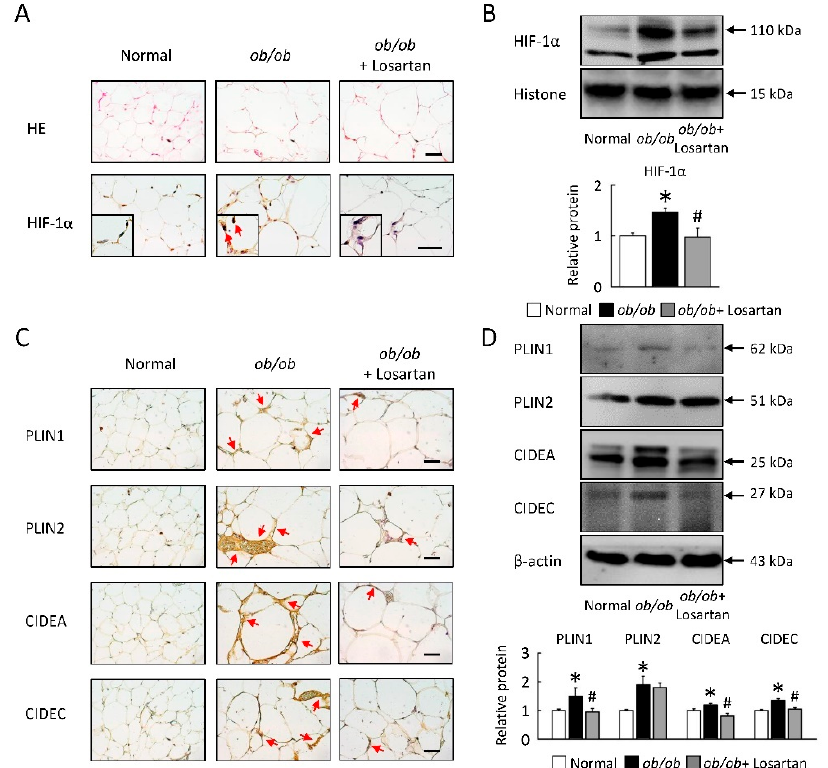
Figure 6. Losartan attenuated HIF-1 α expression and LDs formation in EWAT. ( A ) Representative HIF-1 α staining of EWAT from losartan-treated ob / ob mice and normal mice. Red arrow highlights the positive staining. Scale bar: 100 µ m. Quantification of ( B ) HIF-1 α protein level by Western blot. Below graphs indicate quantification relative to Histone. ( C ) Representative HE, PLIN1, PLIN2, CIDEA and CIDEC staining of EWAT from losartan-treated ob/ob mice and normal mice. Scale bar: 100 μ m. Quantification of ( D ) PLIN1, PLIN2, CIDEA, and CIDEC protein levels by Western blot of EWAT after losartan treatment. Below graphs indicate quantification relative to β -actin. For each animal group, n = 5. All values represent the mean ± SEM. Data were analyzed by Student’s t test. * p ≤ 0.05; normal vs. ob/ob . # p ≤ 0.05; ob/ob vs. ob/ob + Losartan. HIF-1 α , hypoxia-inducible factor-1 α ; LDs, lipid droplets; EWAT, epididymis white adipose tissue; HE, hematoxylin and eosin; PLIN, perilipin; CIDE, cell-death-inducing DNA-fragmentation-factor (DFF45)-like effector.